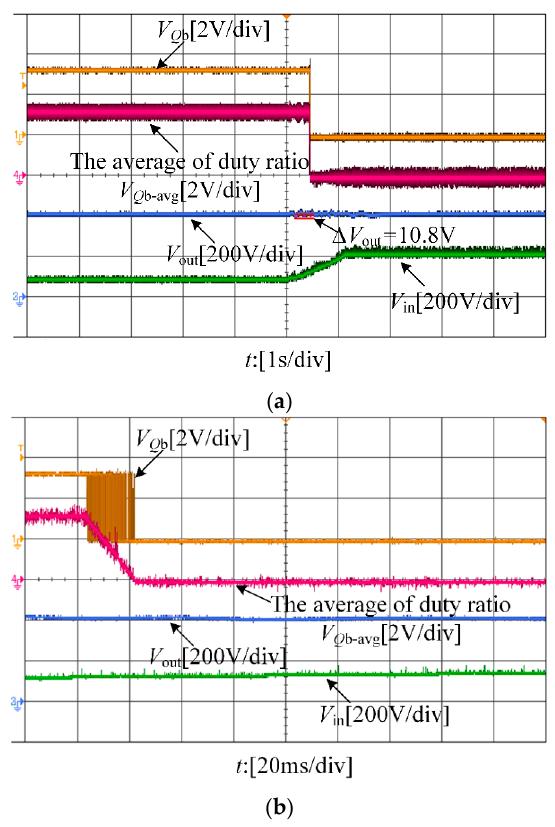
Figure 16. Experimental waveforms of transient switching process a with gradual adjustment control method. ( a ) Overall switching waveforms; ( b ) Enlarge detailed waveforms.